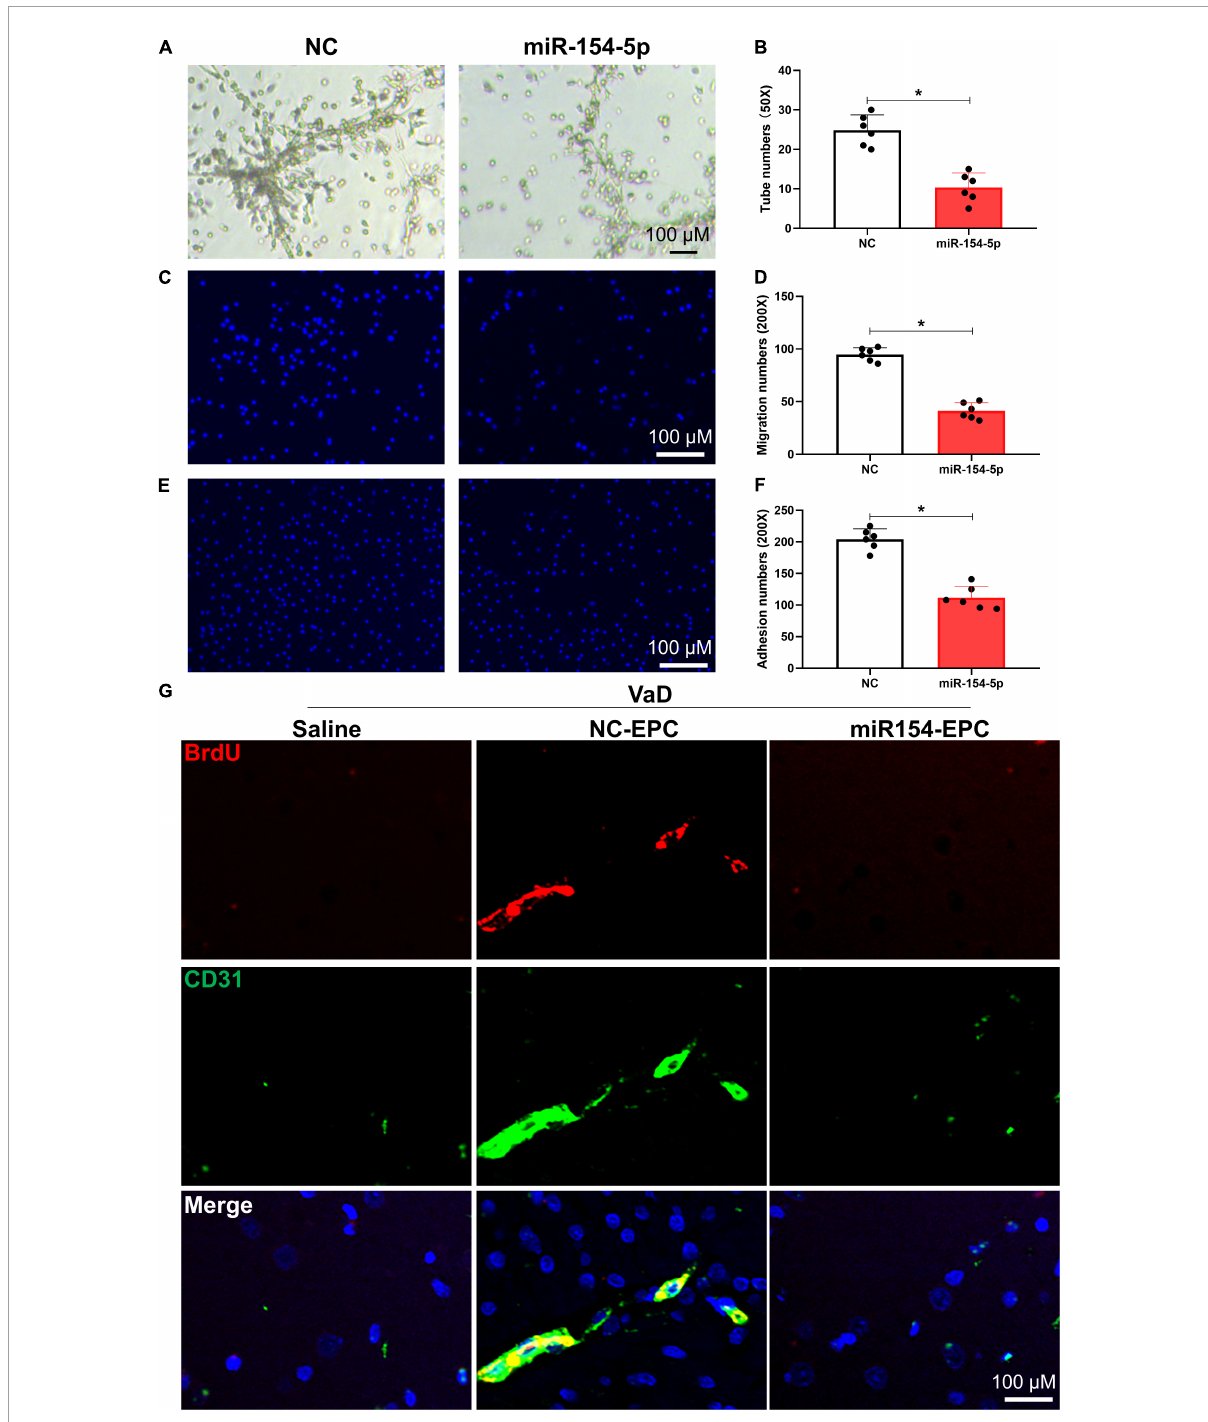
FIGURE5 Overexpression of miR-154-5p impairs EPC functions and inhibits angiogenesis following EPC transplantation in VaD rats. After 7 days culture, BM-EPCs were transfected with normal control (NC) scrambled RNA or miR-154-5p mimics, and EPC functions were then evaluated using tube formation assay (A,B) , migration ability (C,D) , and adhesion capacity (E,F) . (A) : 50 × : scale bar, 100 µ m; (C,E) : 200 × : scale bar, 100 µ m. VaD rats were subjected to a single injection of saline or BrdU-labeled EPCs, which were transfected with NC RNA and miR-154-5p mimics. Seven days later, brain samples were harvested and stained with CD31 (green) and BrdU (red). (G) Representative images in the cortex region of VaD rats. 200 × : scale bar, 100 µ m [ (A–F) : n = 6; (G) : n = 3]. * p < 0.05. Data are shown as mean ± SD. BrdU, 5-bromo-2 (cid:48) -deoxyuridine; EPC, endothelial progenitor cell; VaD, vascular